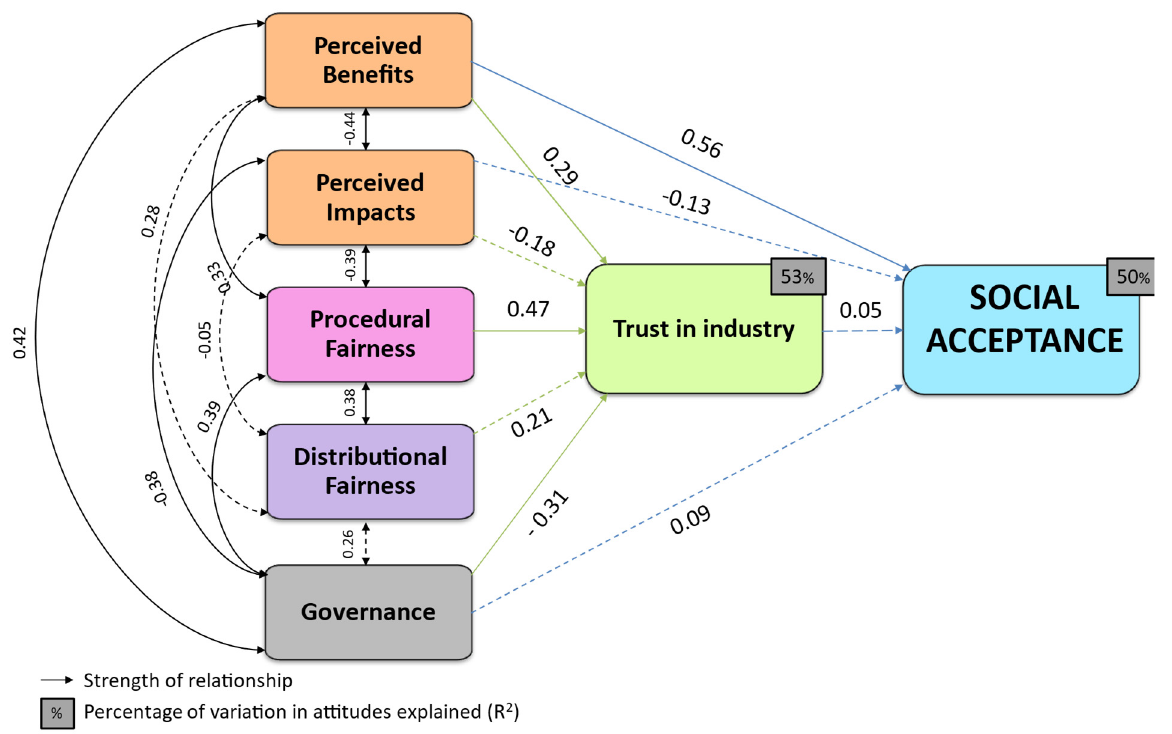
Figure 2. Simple SEM model based on the hypotheses of Moffat et al. (2017) as described in 3.5. Block lines represent statistically significant relationships; dashed lines are not statistically significant at a 95% confidence level. Standardised regression coefficients (beta weights) above the arrows signify the strength of relationship between the SLO variables. Percentages in the grey boxes above the dependent variables represent the variances of the respective variable explained by the model. The SLO variables are colour-coded. The colour of the arrow signifies which dependent variable is explained.